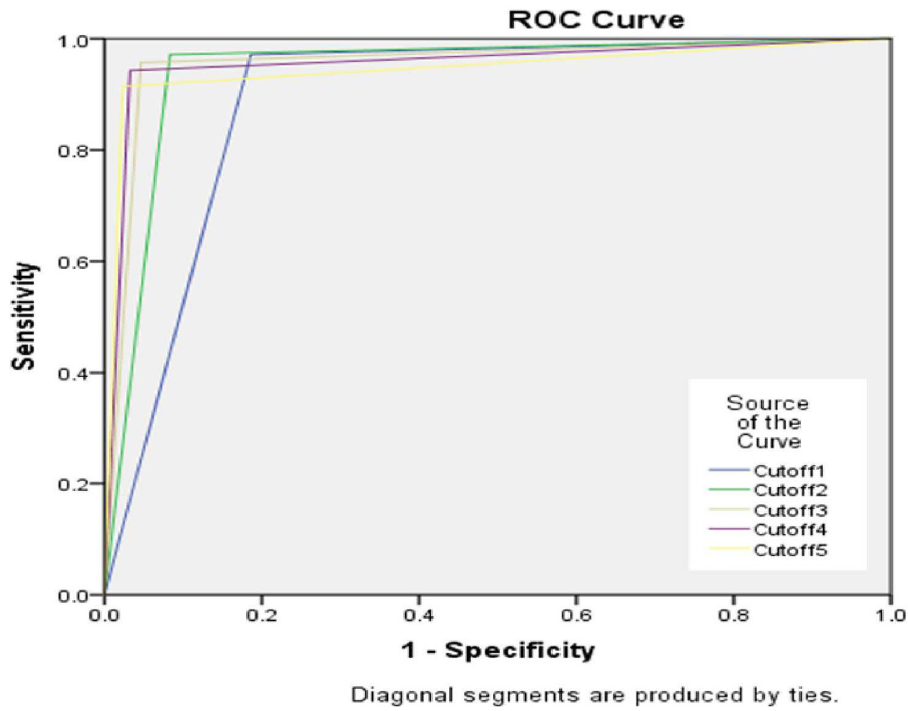
Fig 2. Receiver operating characteristic (ROC) curve analysis of IASQ against CARS2 (n = 285).